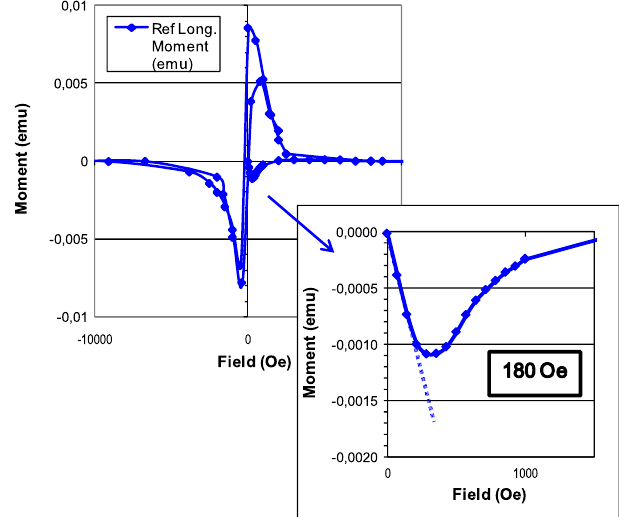
FIG. 3. Magnetization curves at 4.5 K for the reference sample (250 nm Nb): longitudinal moment. The inset shows the deter- mination of the first penetration field B P . As expected for an isotropic superconductor, B P is found the same in the transverse direction (not